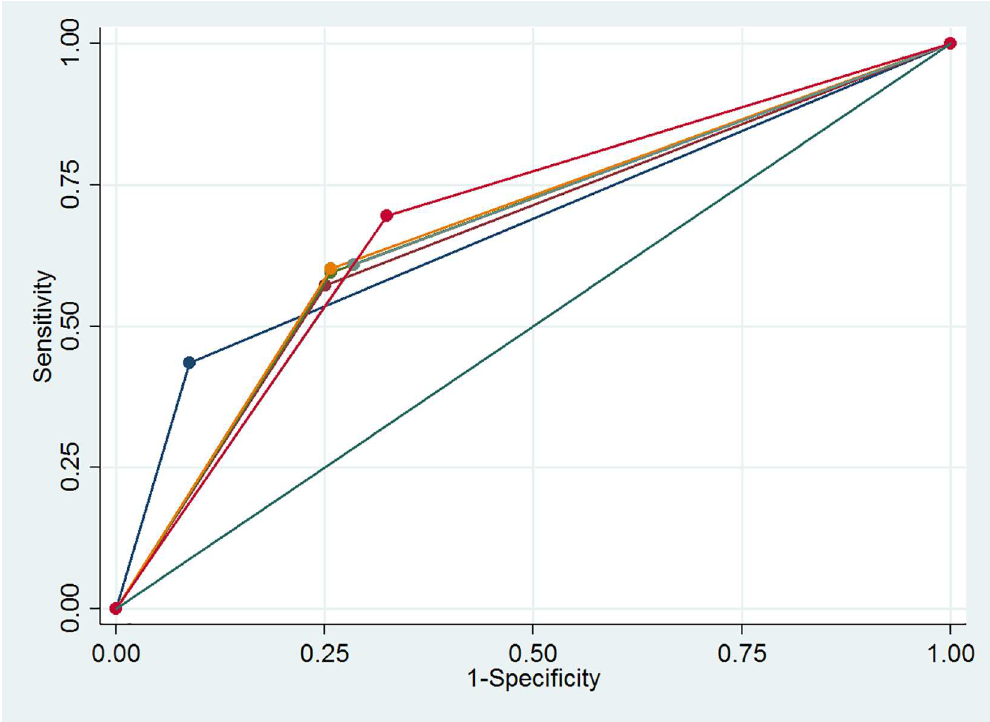
Fig 4. ReceiverOperating Curves (ROC) with Area under the Curve (AUC) for each component of the screening tool for confirmed and probable cases (n = 138). Dark blue: Cough (cid:21) 2 weeks, brown: Cough (cid:21) 2 weeks + weight loss, green: Cough (cid:21) 2 weeks + weight loss + night sweats (cid:21) 3 weeks, orange: Cough (cid:21) 2 weeks + weight loss + night sweats (cid:21) 3 weeks + fever (cid:21) 3 weeks, light blue: Cough (cid:21) 2 weeks + weight loss + night sweats (cid:21) 3 weeks + fever (cid:21) 3 weeks + known TB contact, red: Cough (cid:21) 2 weeks + weight loss + night sweats (cid:21) 3 weeks + fever (cid:21) 3 weeks + TB contact.